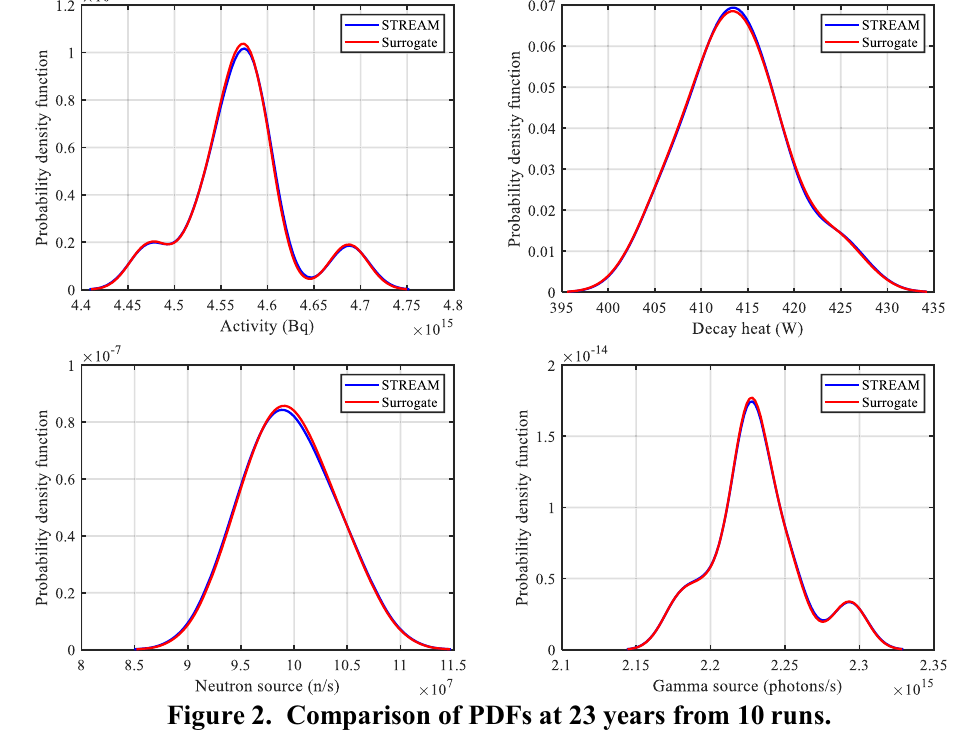
Figure 2. Comparison of PDFs at 23 years from 10 runs.